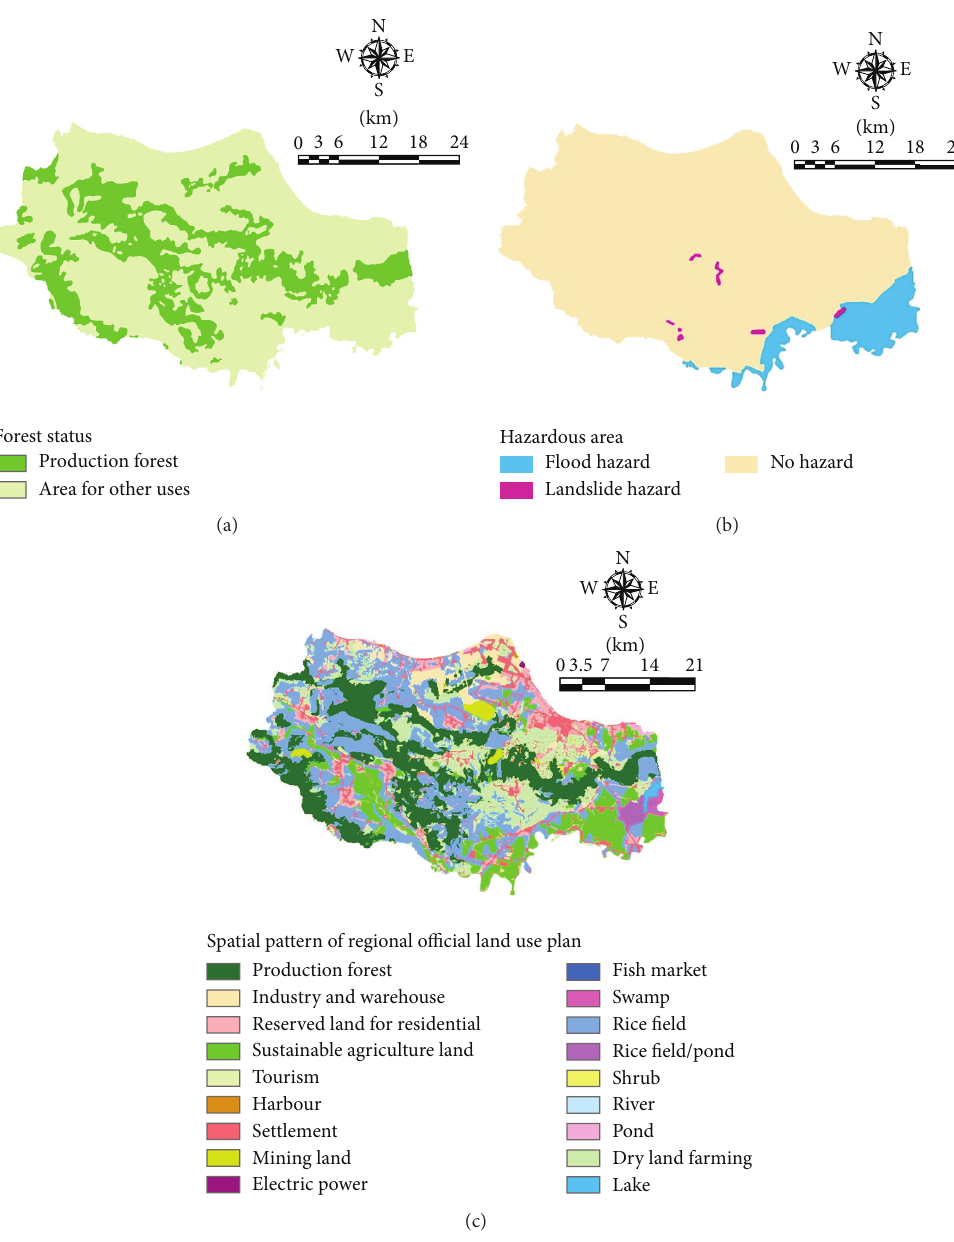
Figure 4: Maps used for analysis of land availability: (a) FASD map 1,3 , (b) flood hazard and landslide hazard presented in SP-ROLUP 2 , and (c) land allocation in SP-ROLUP map 2,3 (source of figures: 1 [12]; 2 [13]; 3